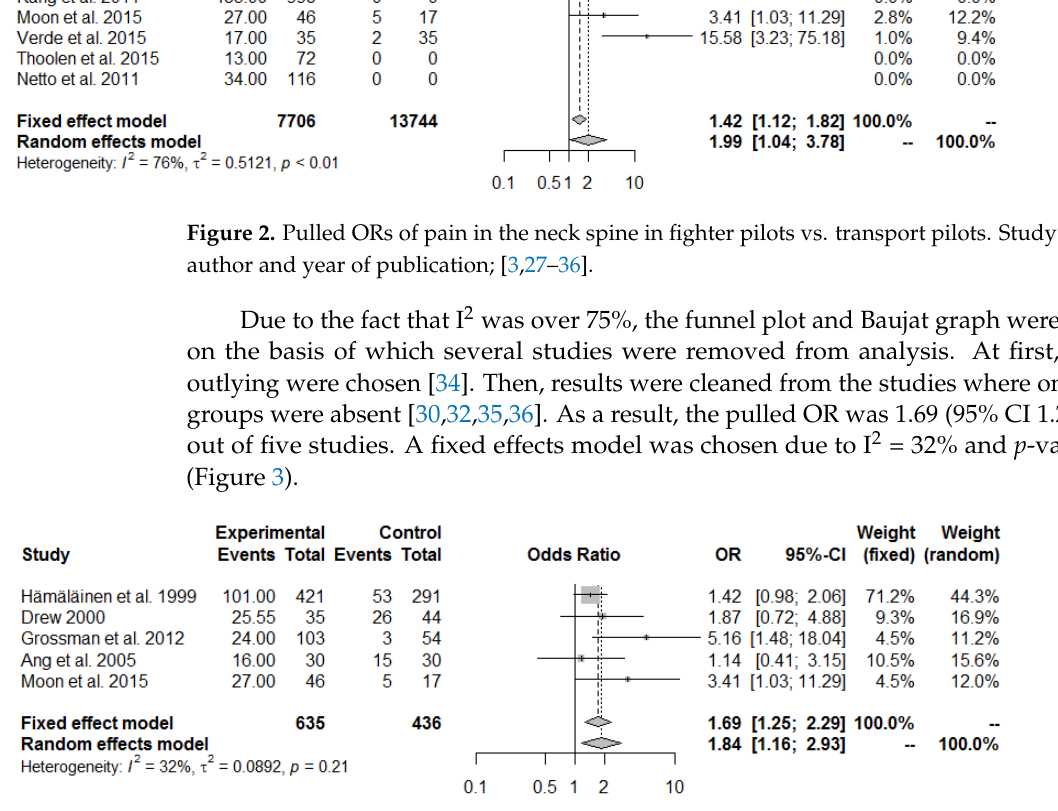
Figure 3. Pulled ORs of pain in the neck spine in fighter pilots vs. transport pilots. Study shows